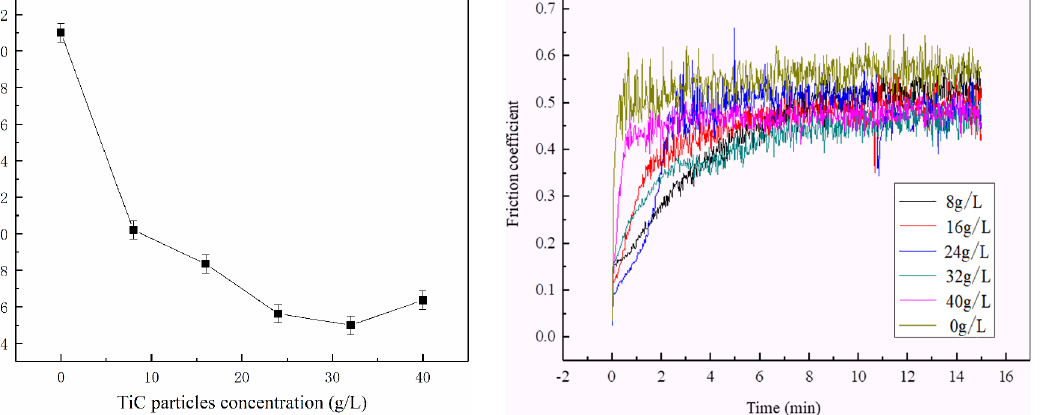
Figure 12. Effects of TiC concentration on the friction coefficient of Ni-TiC composite